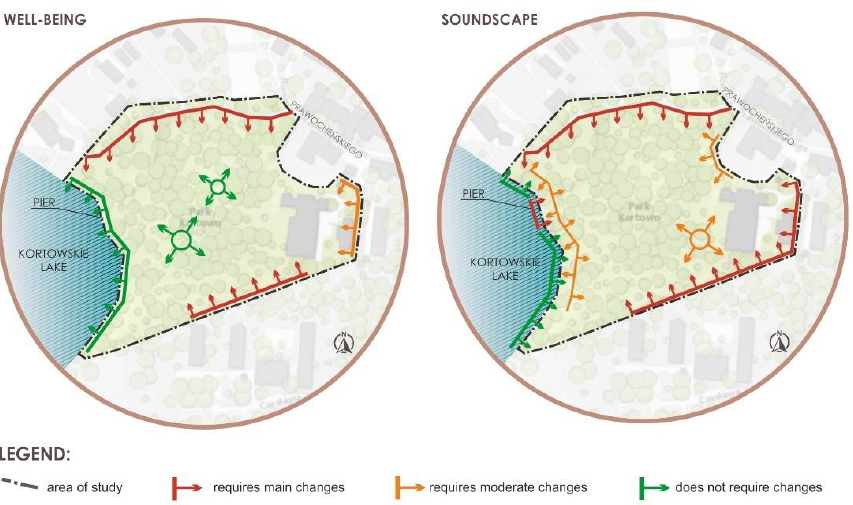
Figure 8. Zones requiring high and medium intervention and zones not requiring changes.